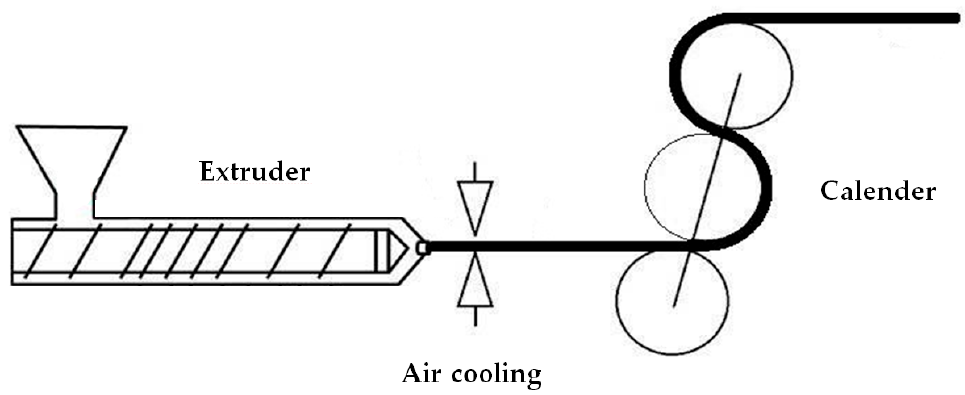
Figure 1. Summary outline of the fabrication of the precursor films.